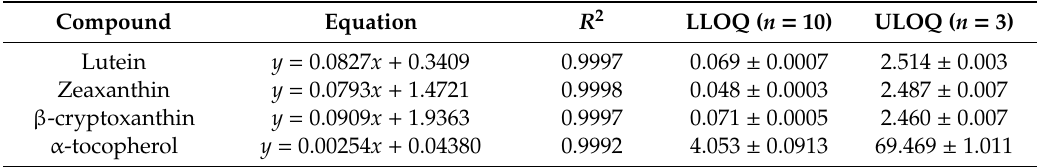
Table A4. Regression line, lower and upper limits of quantification for xanthophyll carotenoids and vitamin E.